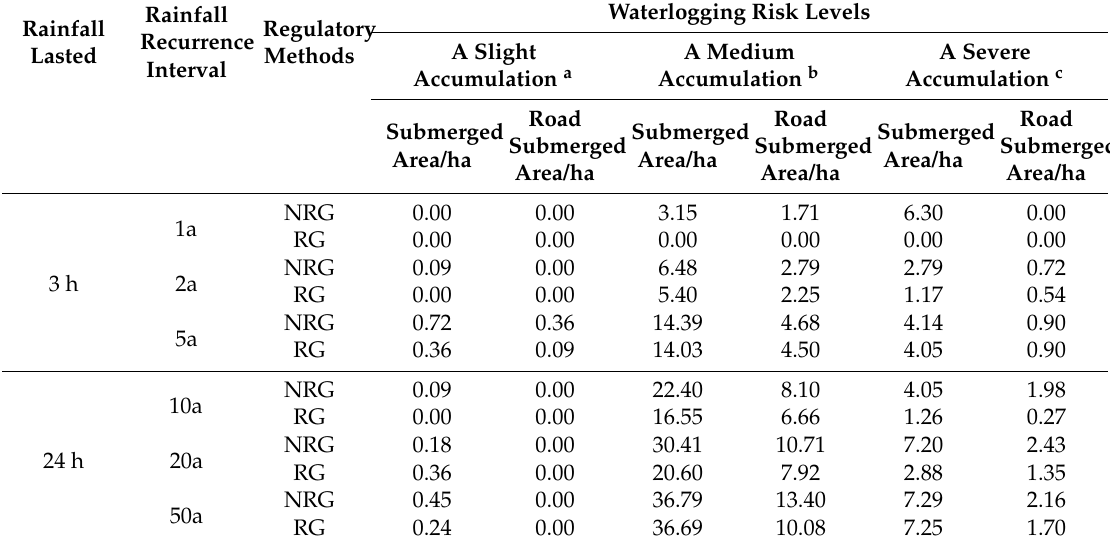
Table 7. Classification standard and area statistics of